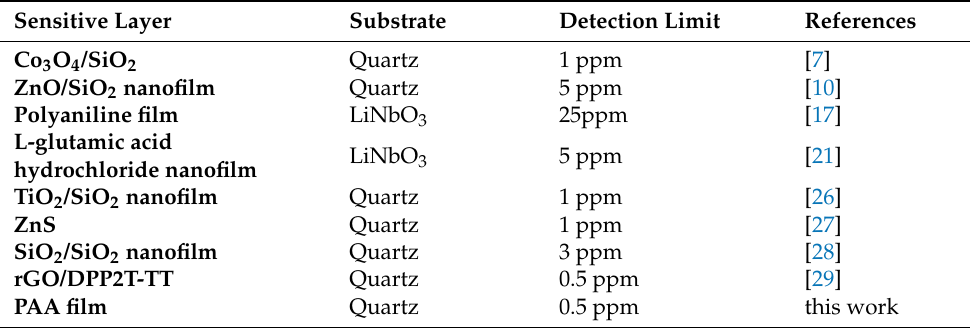
Table 1. Summary of the detection limits of various ammonia SAW sensors.